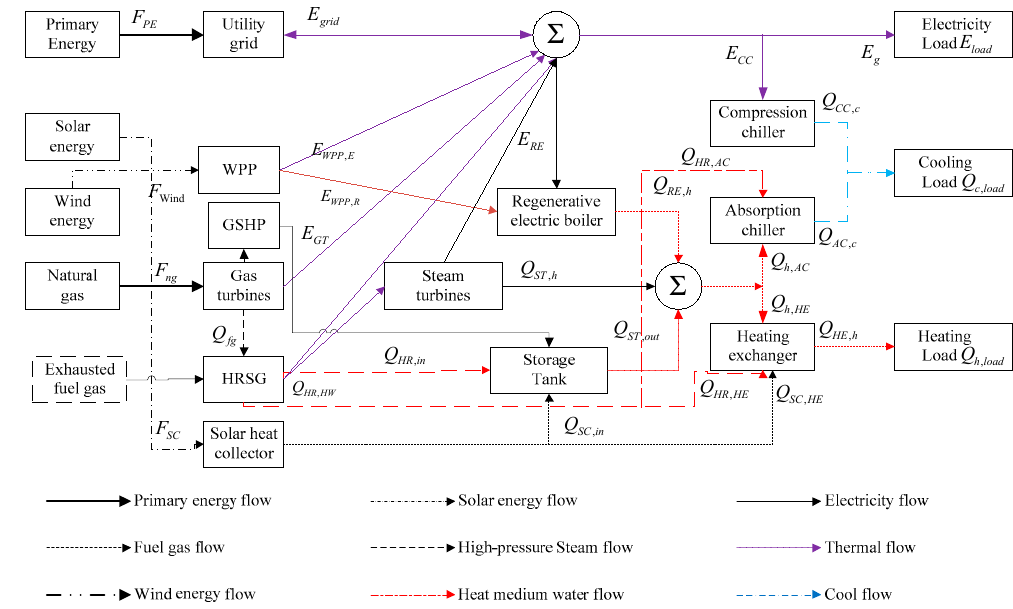
Figure 1. Combined cooling, heating, and power (CCHP) system based on thermal energy storage and ground-source heat pump. WPP: wind power plant; GSHP: ground-source heat pump; HRSG: heat recovery steam generators.